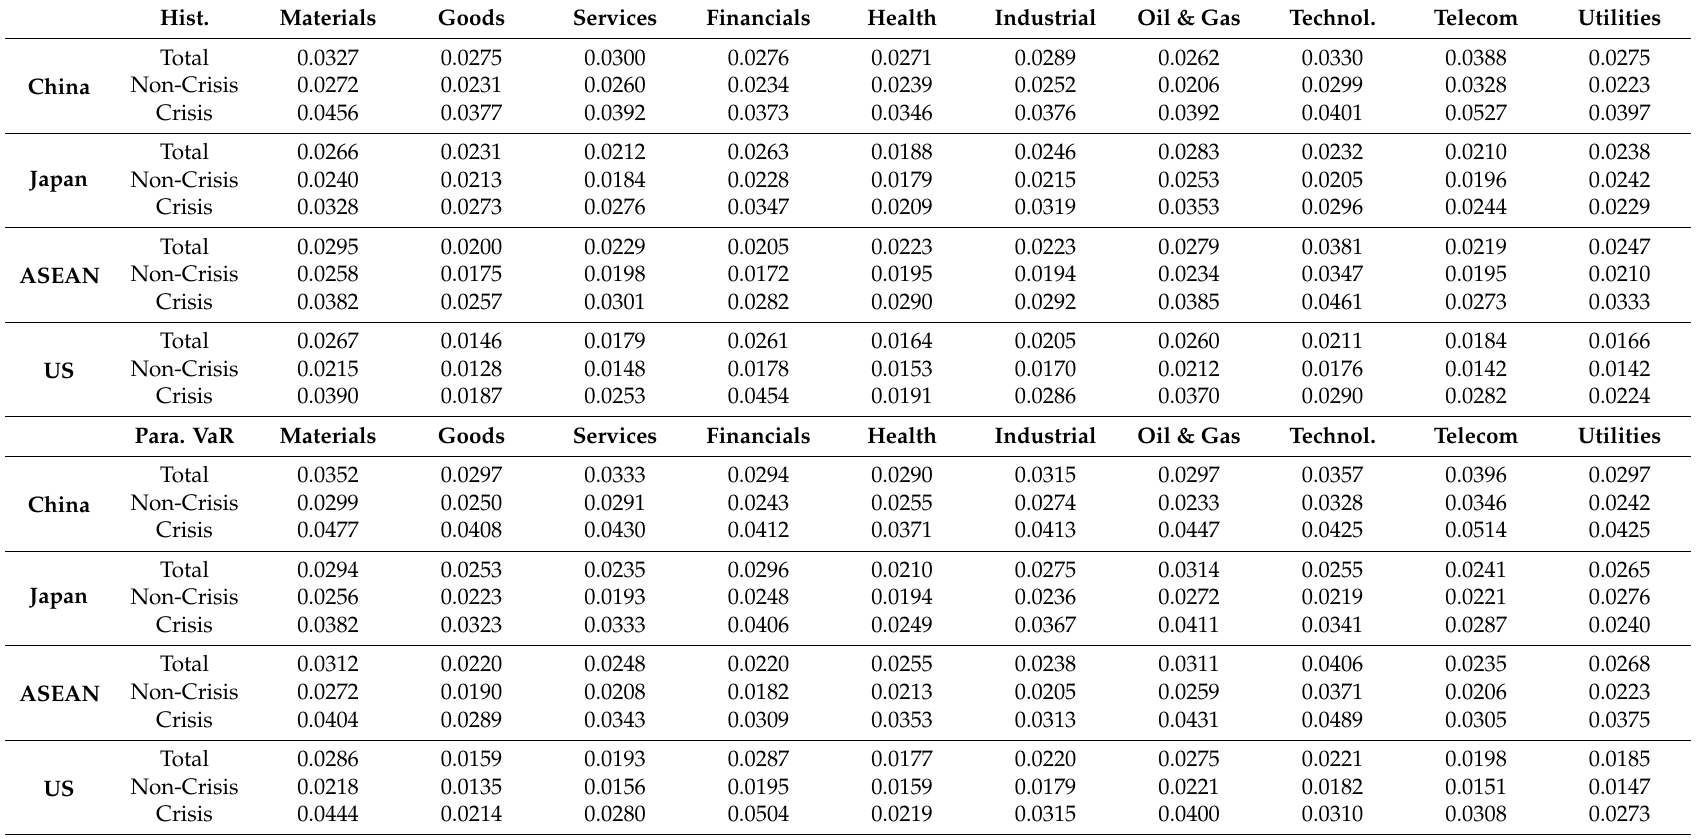
Table A1. 95% VaR and CVaR per industry: